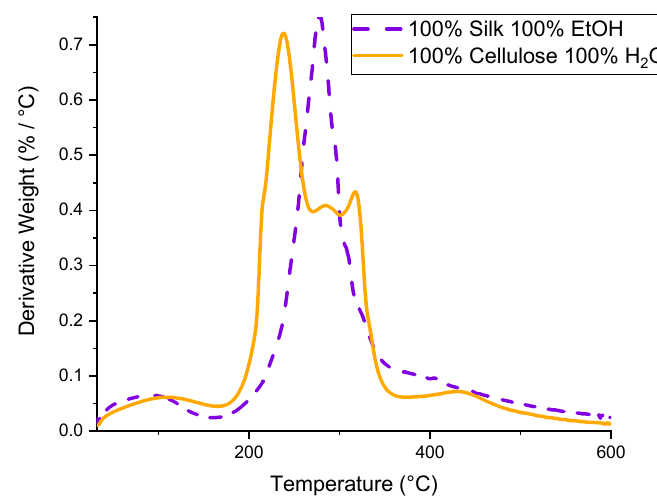
Figure 4. Derivative weight-loss percentage plots of the varied composition biocomposite films as well as 100% regenerated samples, used to determine T ∆ Max as well as other characteristic temperatures. Table 2. Start and end temperatures, total weight-loss percentage, and the maximum temperature of the derivative are used to characterize thermal gravimetric analysis (TGA) results of the 100% regenerated samples and varied composition samples.